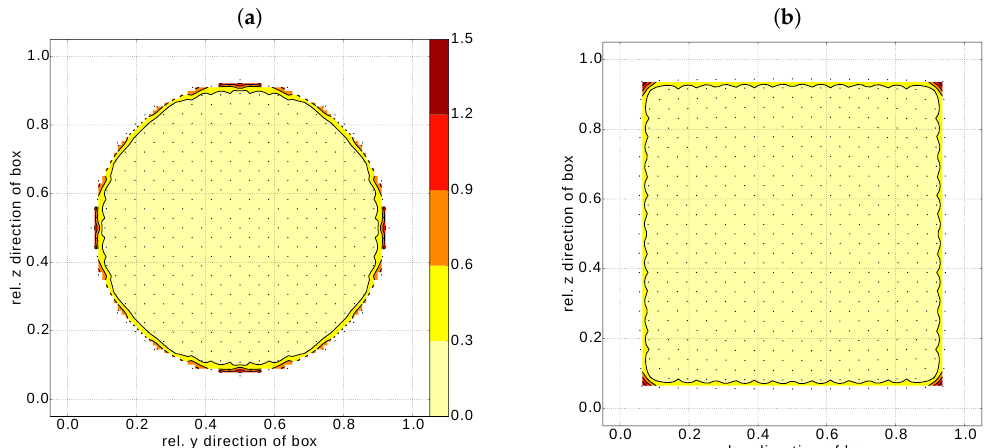
Figure 7. Contour plots of the distribution of the surface stress induced excess energy (in eV/at.) contribution for a cross section of ( a ) a nanoshere ( R = 3.25nm) and ( b ) a nanocube ( a = 6.92nm). Both cross sections include the nanoparticle centre. The dots represent actual atoms in the cross section, e.g., real locations, where the excess energy is stored. For sake of clear demonstration, the discrete data were interpolated over the whole cross sectional